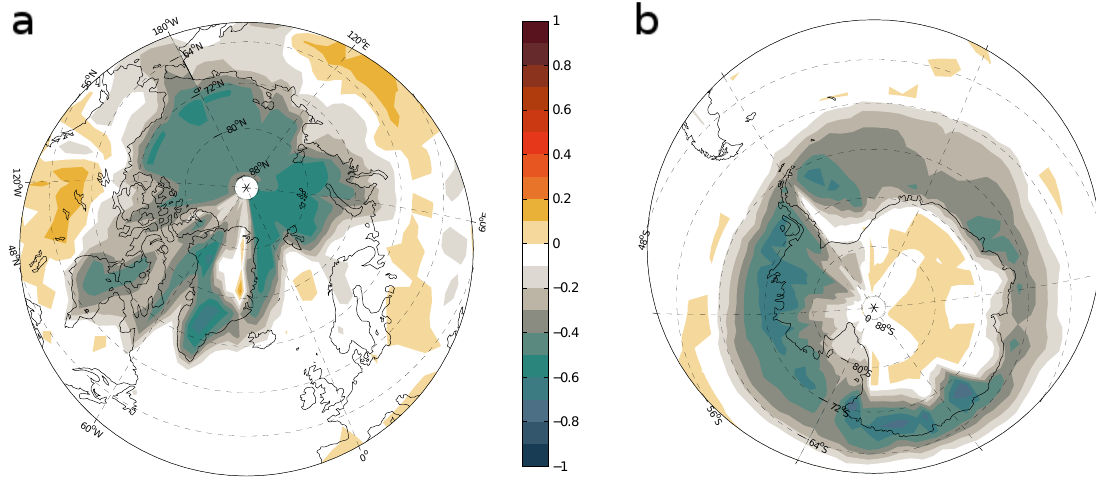
Fig. 7. Differences in albedo between mid-Pliocene and pre-industrial scenarios as calculated from upward and downward radiative fluxes for (a) northern, and (b) southern high latitudes.